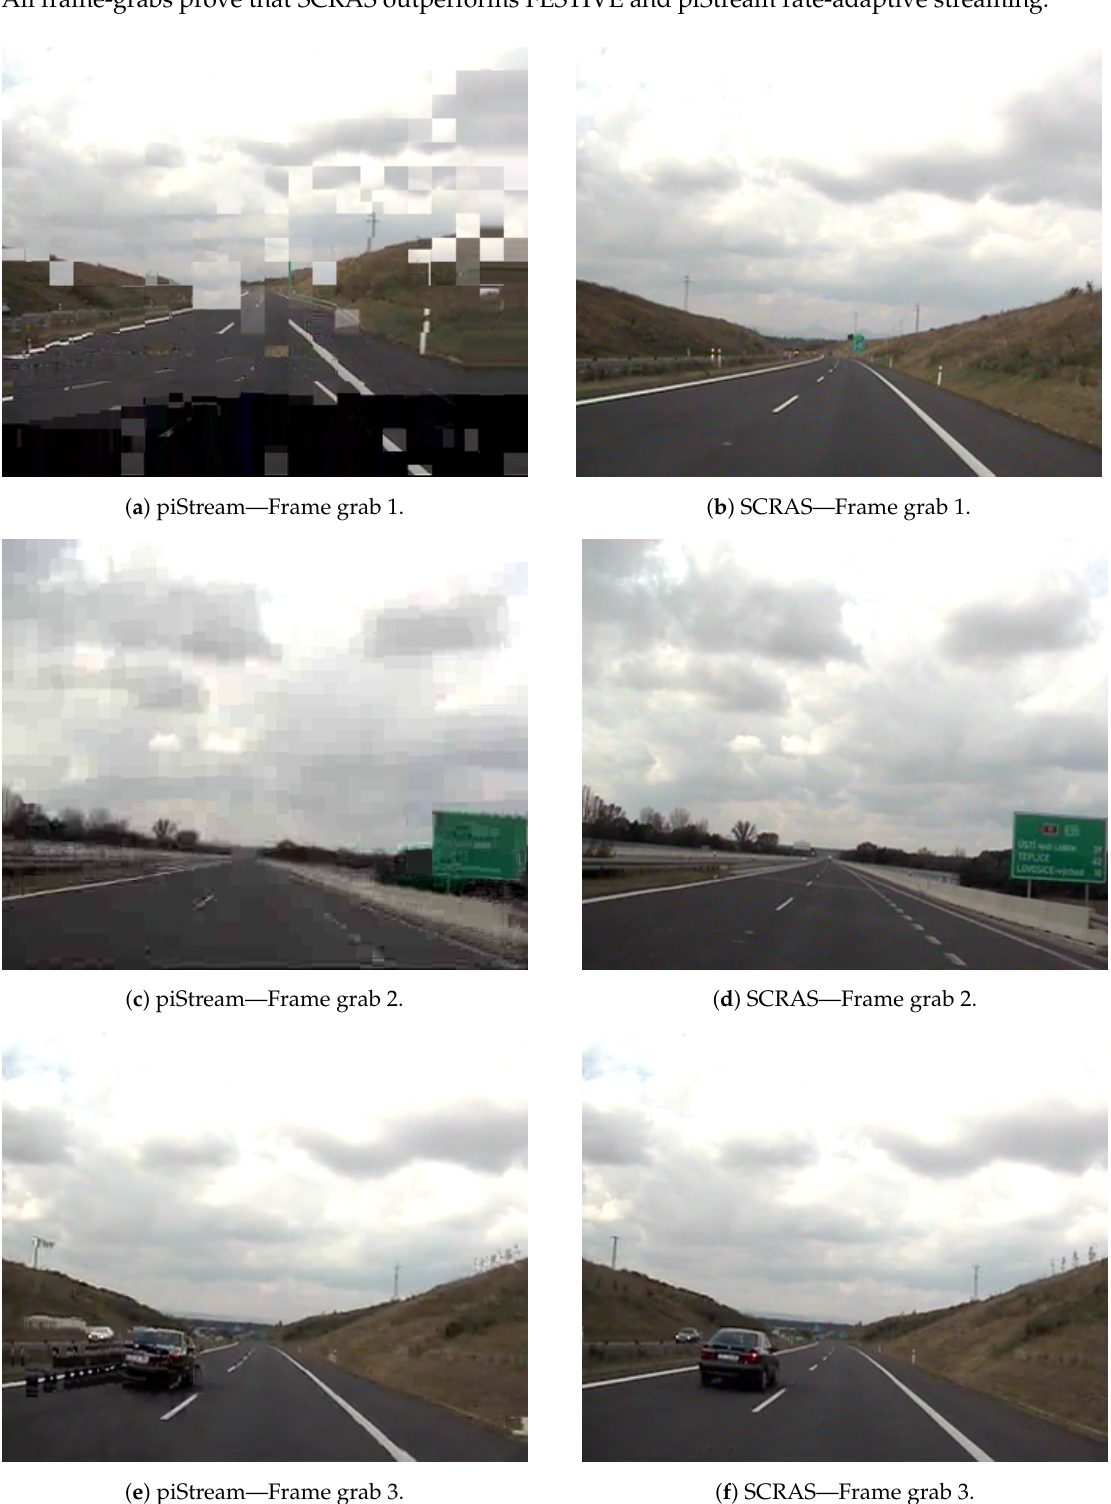
Figure 12. Frame-grabs of streaming video showing SCRAS outperform piStream after